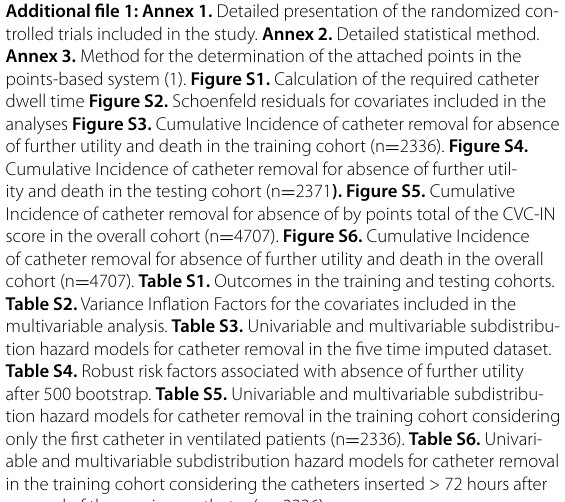
Table S4. Robust risk factors associated with absence of further utility after 500 bootstrap. Table S5. Univariable and multivariable subdistribu‑ tion hazard models for catheter removal in the training cohort considering only the first catheter in ventilated patients (n 2336). Table S6. Univari‑ = able and multivariable subdistribution hazard models for catheter removal in the training cohort considering the catheters inserted > 72 hours after removal of the previous catheter (n =